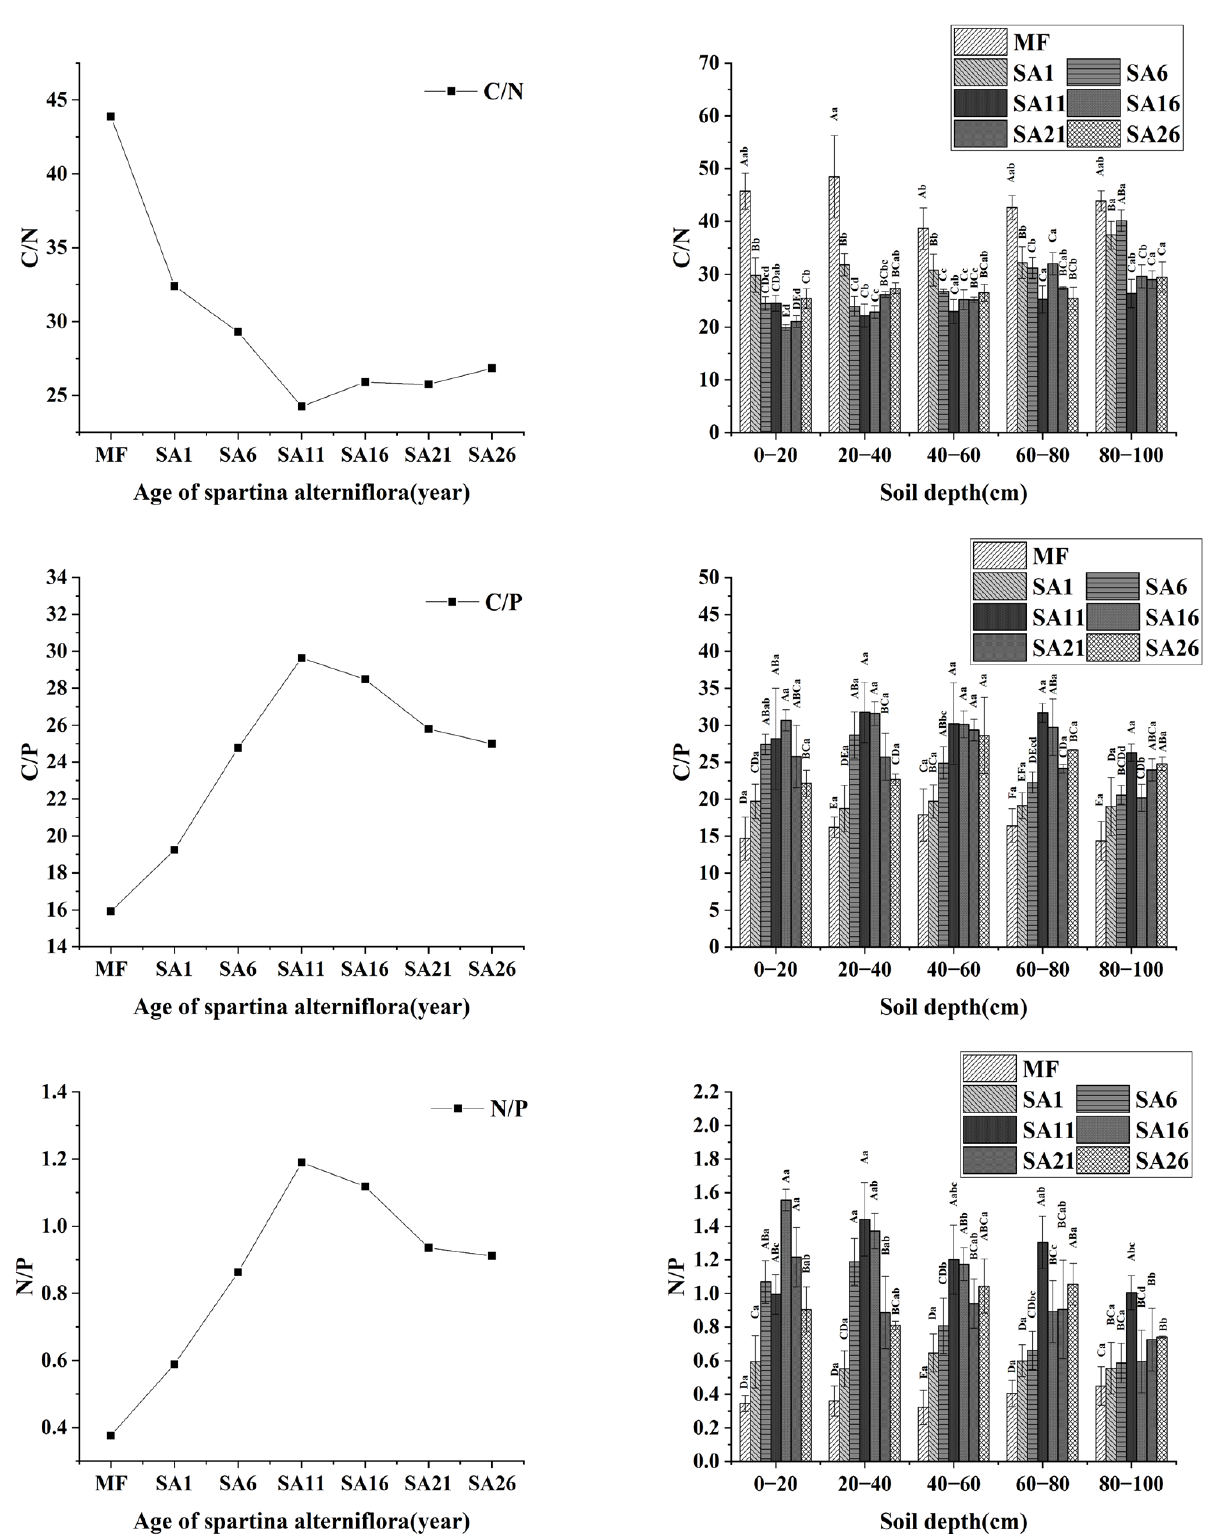
Figure 6. Ecological stoichiometry of soil C, N and P at different stages of invasion. Different letters indicate significant differences between different years of invasion or soil depths. ( p < 0.05).